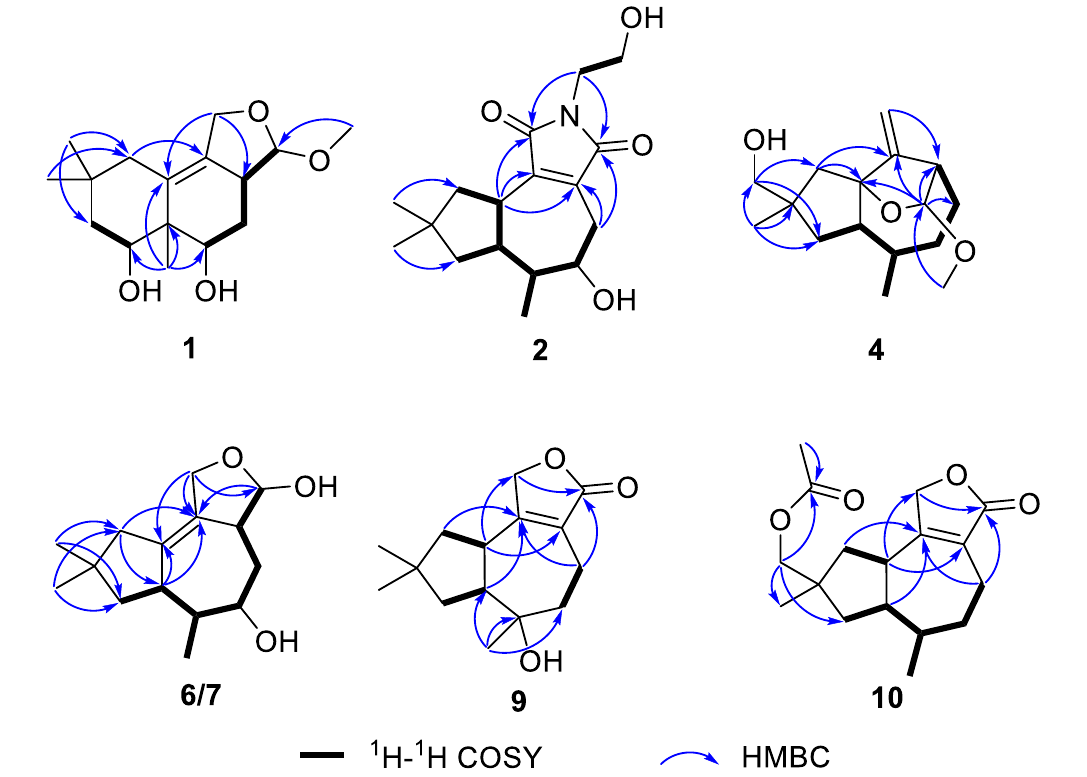
Fig. 2 Key 1 H- 1 H COSY and HMBC correlations of compounds 1 , 2 , 4 , 6 / 7 , 9 , and 10